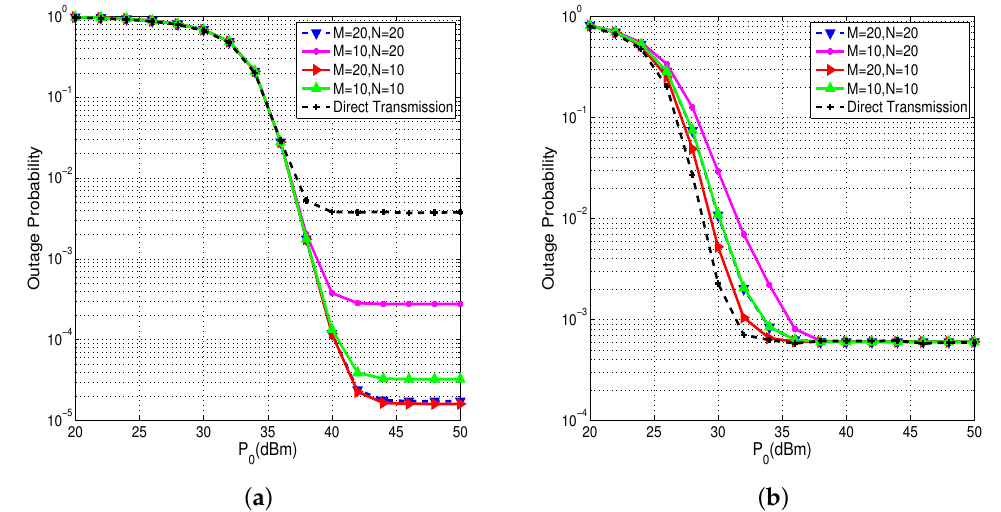
Figure 4. Outage probability of sensor in far and near cluster versus the HAP transmit power P 0 with different cluster scales. ( a ) far cluster; ( b ) near